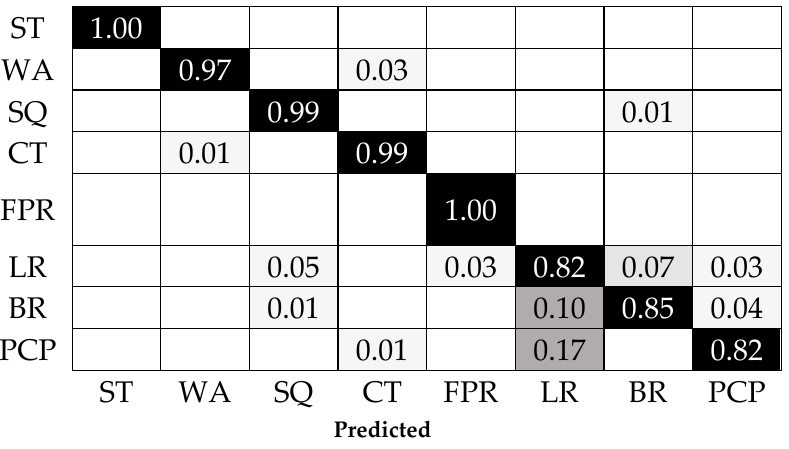
Figure 10. Confusion matrix of CART classification for eight activities.